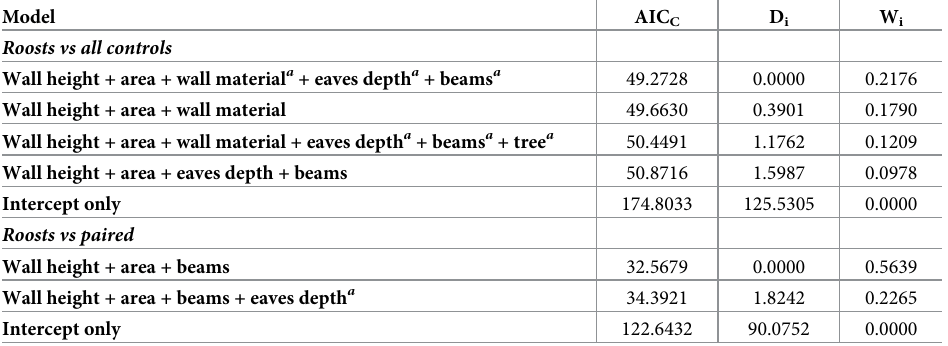
Models built with binomial distribution and logit link. Intercept models included for comparisons under conditions of no roost selection. D i represents delta (AIC C ) and indicates the difference in the AIC C value with the top model. The symbol ‘a’ denotes non-significant terms based on 0.05 significance